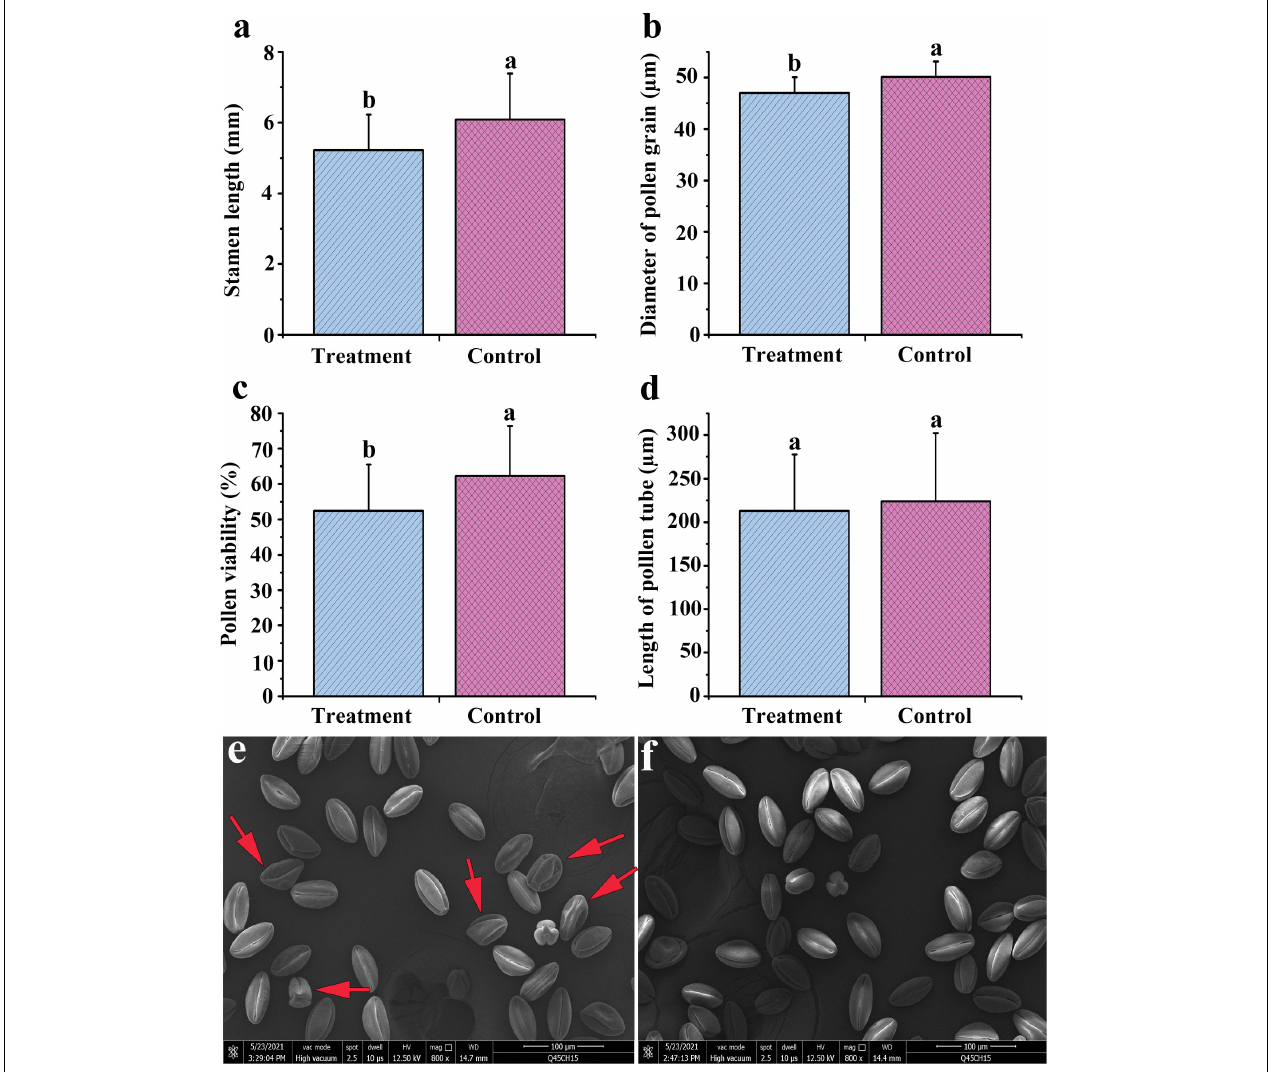
FIGURE 6 | Stamen and pollen development in androecious “Yunjiashan Yeshi” trees, compared between control and combined treatment with exogenous zebularine, 5-azacytidine, ethrel, and ZT. (a–d) Comparison of phenotypic traits between treated and control samples. (e,f) Electron microscopy comparisons of pollen grains in treated and control